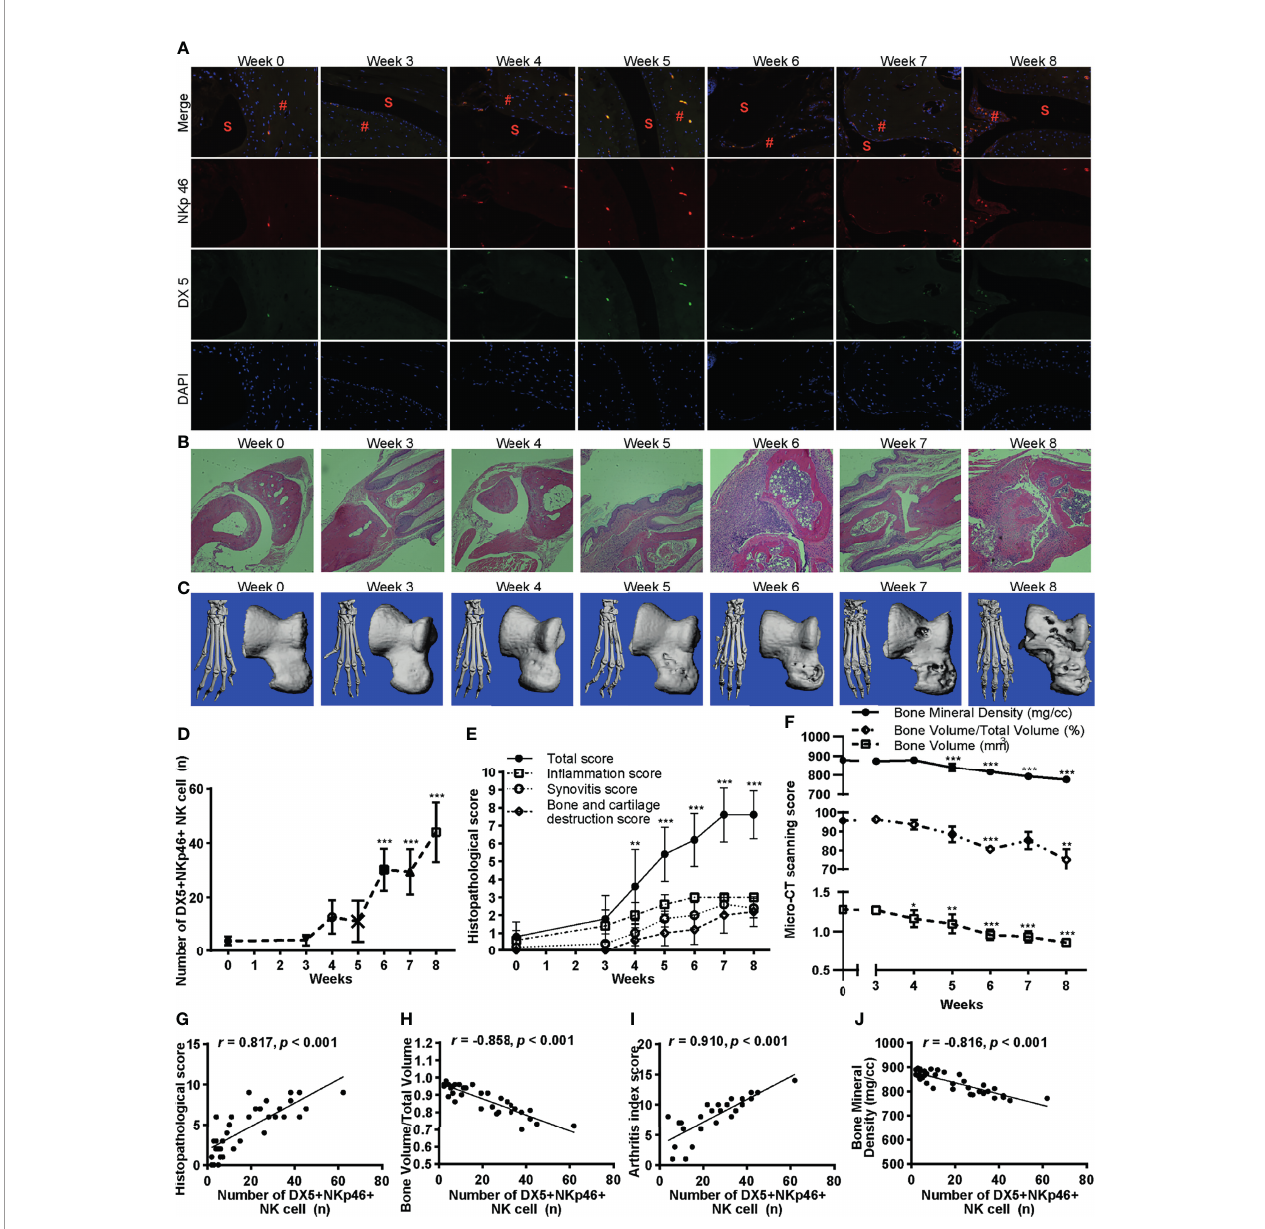
FIGURE 4 | In fi ltration of NKp46 + NK cells correlates with in fl ammation and bone erosion. (A) Representative images of immuno fl uorescence examination of NKp46 + NK cells in hind paws. Cells were stained with anti-NKp46 (red) and anti-DX5 antibodies (green), and nuclei were stained with DAPI (blue), ×100 magni fi cation. S, synovial space; #, synovial tissue. (B) Representative histological staining (H&E, ×100 magni fi cation). (C) Reconstructed micro-CT 3D models of the claw (left) and talus (right). (D – F) Changes of the number of DX5 + NKp46 + NK cells, histopathological score, and micro-CT quantitative measurements of bone destruction over disease progression, respectively. ANOVA with post-hoc LSD test for all except that ANOVA with post-hoc Dunnett ’ s T3 test for bone volume/total volume. *p < 0.05, **p < 0.01, ***p < 0.001 vs. week 0. n = 5 per group. (G – J) Correlations of the DX5 + NKp46 + NK cells in the joints with histopathological score, bone volume to total volume, arthritis index score, and bone mineral density, respectively. Spearman correlation analyses were used. n = 5 per group. Results are representative of three independent